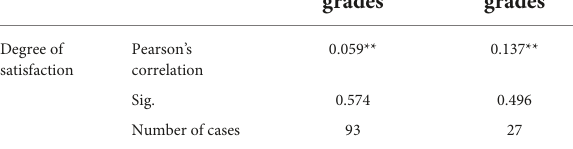
TABLE 4 Correlation analysis of learner satisfaction and learners’ grades.